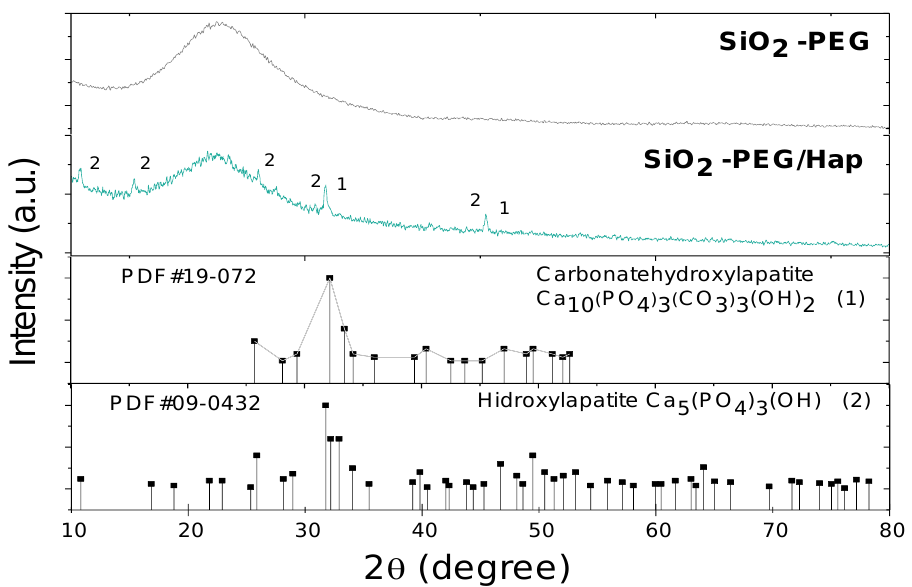
Figure 5. X-ray diffractogram of the SiO 2 -PEG before and after being submerged in the simulated body fluid (SBF) solution for 21 days.